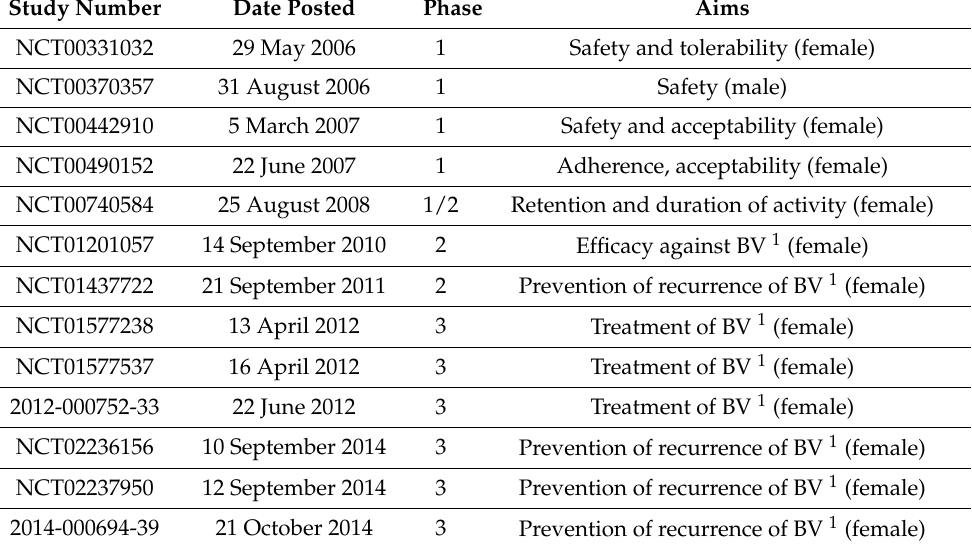
Table 1. Clinical trials with VivaGel®. Information taken from https://ClinicalTrials.gov (accessed on 2 August 2022) for NCT numbers and from https://www.clinicaltrialsregister.eu (accessed on 2 August 2022) for the other